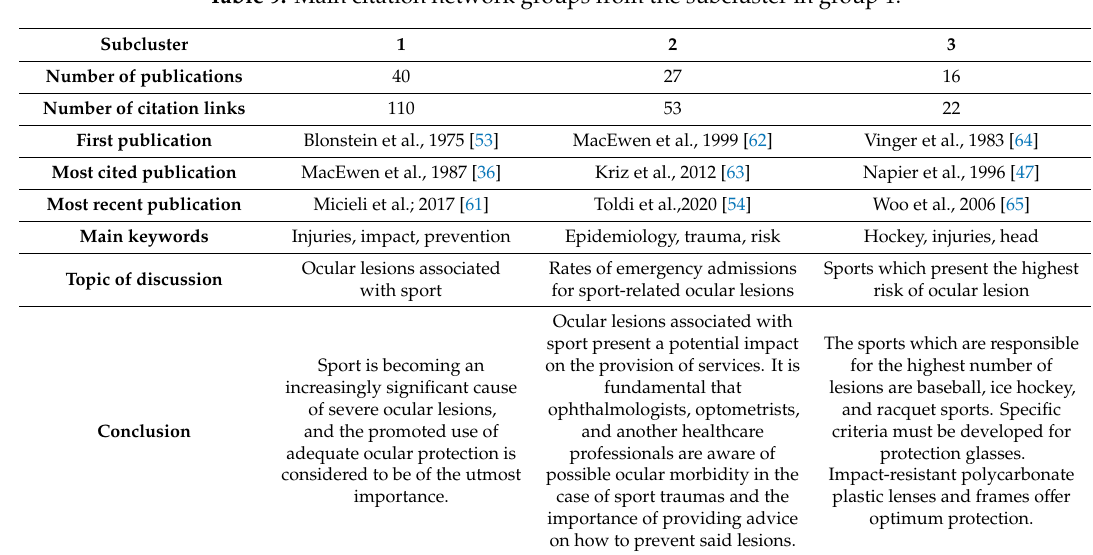
Figure 9. Citation network of subclusters in group 1. Table 9. Main citation network groups from the subcluster in group 1.